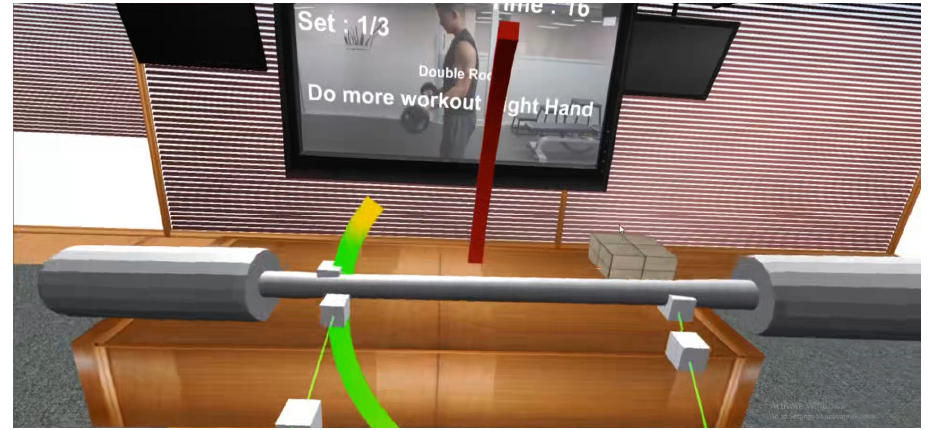
Figure 12. Barbell curl process.